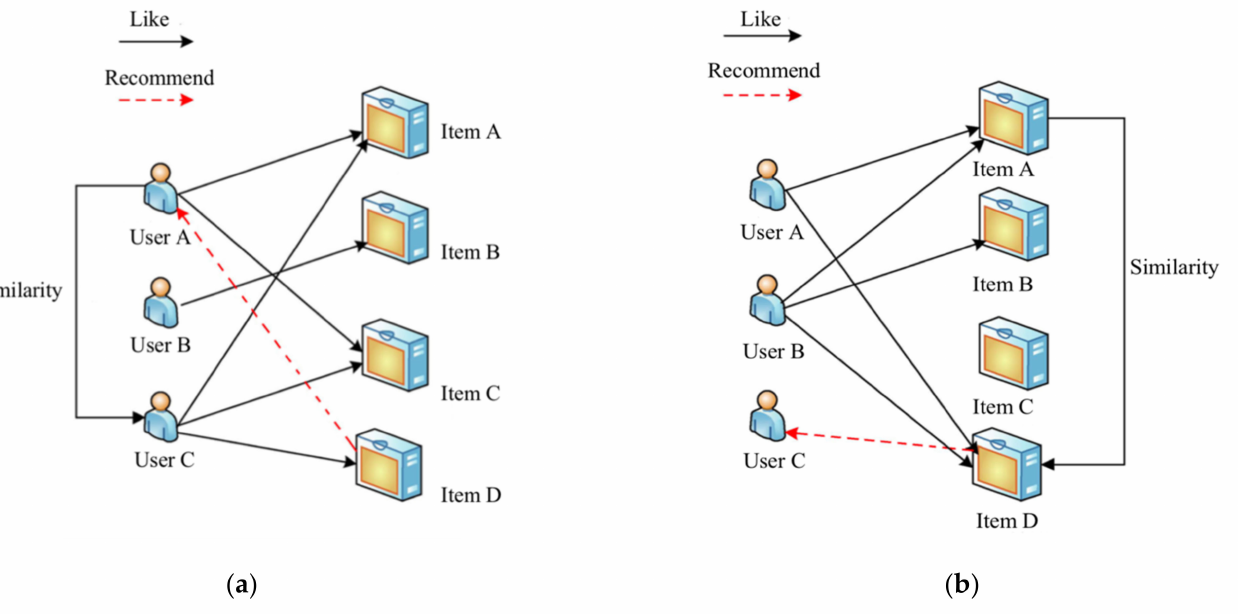
Figure 1. The ideas of the collaborative filtering algorithm. ( a ) User-based collaborative filtering algorithm; ( b ) content-based collaborative filtering